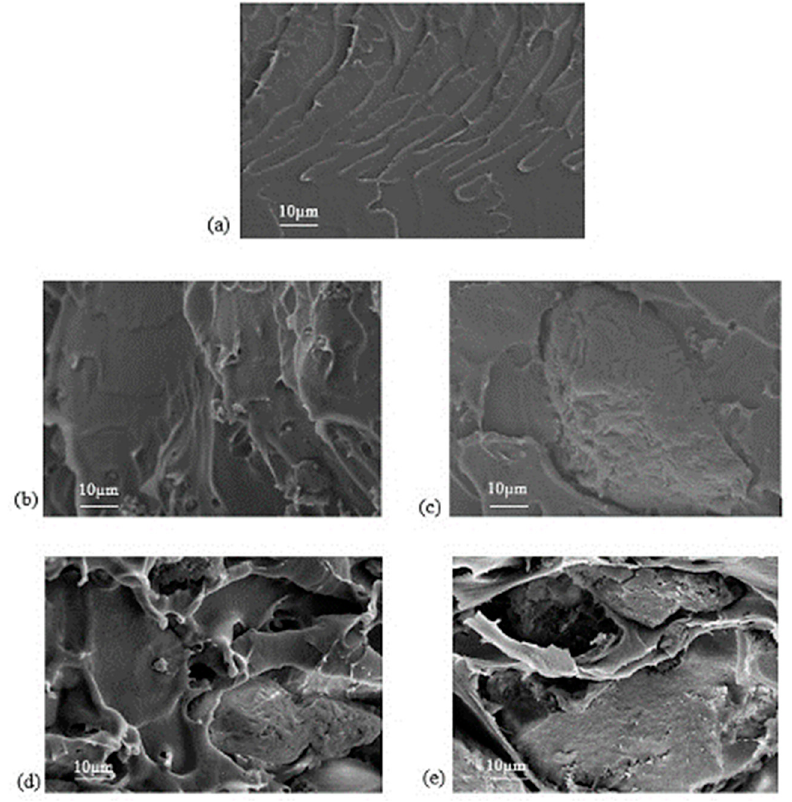
Figure 6. The cross-sectional images of ( a ) pristine PSF membrane; ( b ) 2%-KIT-6 / PSF; ( c ) 4%-KIT-6 / PSF; ( d ) 6%-KIT-6 / PSF; and ( e ) 8%-KIT-6 / PSF.